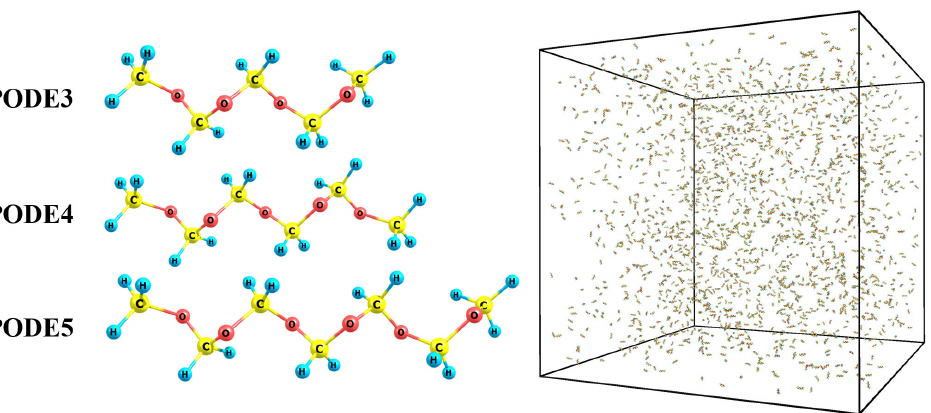
Figure 1. 3D structure of PODE3-5 and initial configurations of the reaction system of 2000 PODE3 (42,000 atoms).